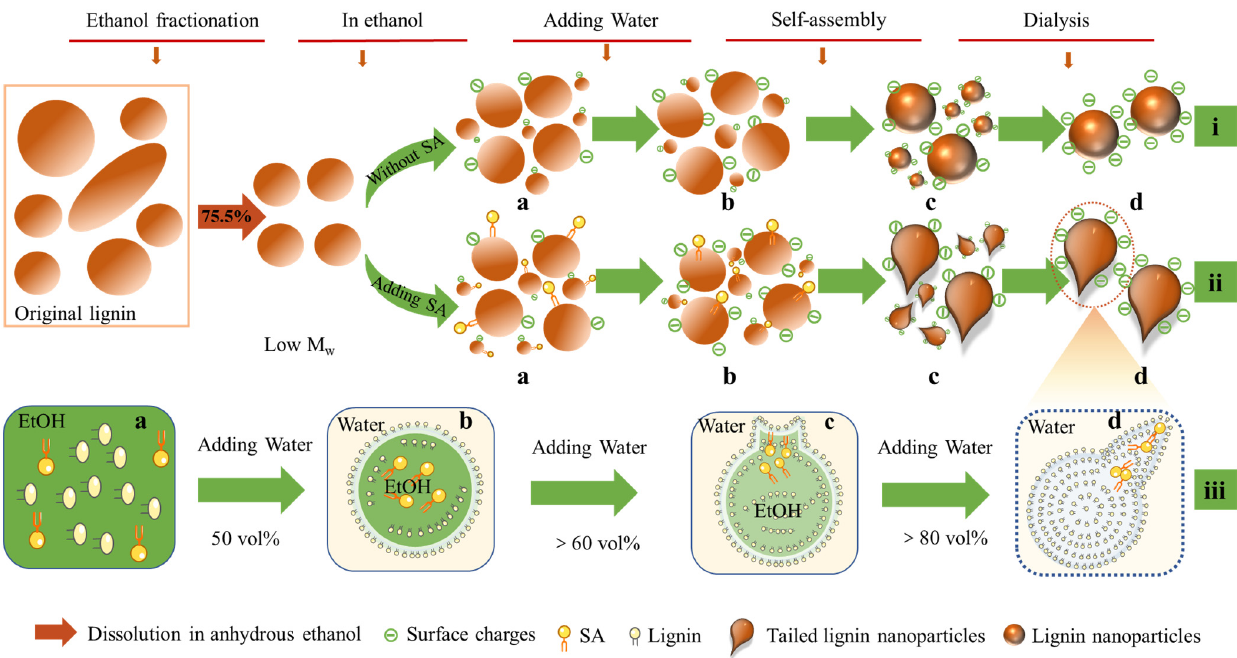
Figure 2. Schematic showing the formation of lignin nanoparticles during the self-assembly process. Route i: Using low molecular weight organosolv lignin as raw materials, ethanol and water as sol- vent and anti-solvent, lignin nanoparticles were obtained by self-assembly method. Route ii : Tailed lignin nanoparticles were obtained from low molecular weight organosolv lignin using the solvent (ethanol)-antisolvent (water) method with the assistance of syringaldehyde. Route iii : Schematic representation of formation process of the tailed lignin nanoparticles with tunable structures.